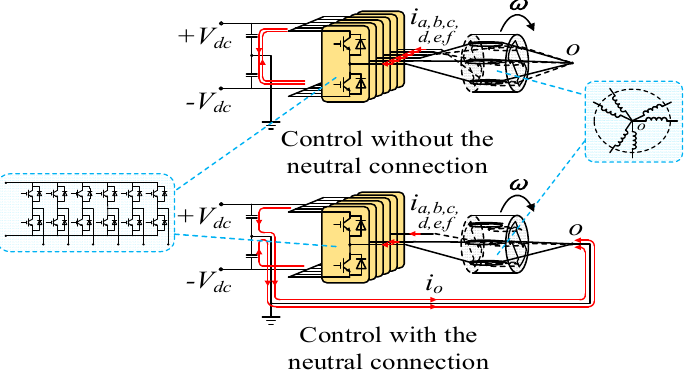
Figure 3. The connection between the PMSM neutral point and voltage midpoint of converter’s DC side.